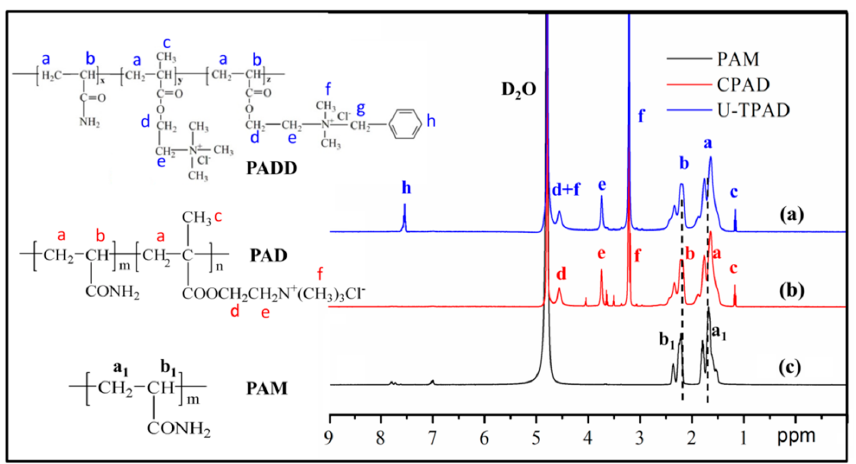
Figure 4. The 1 H nuclear magnetic resonance ( 1 H NMR) spectra of ( a ) PAM, ( b ) PAD, and ( c ) PADD.